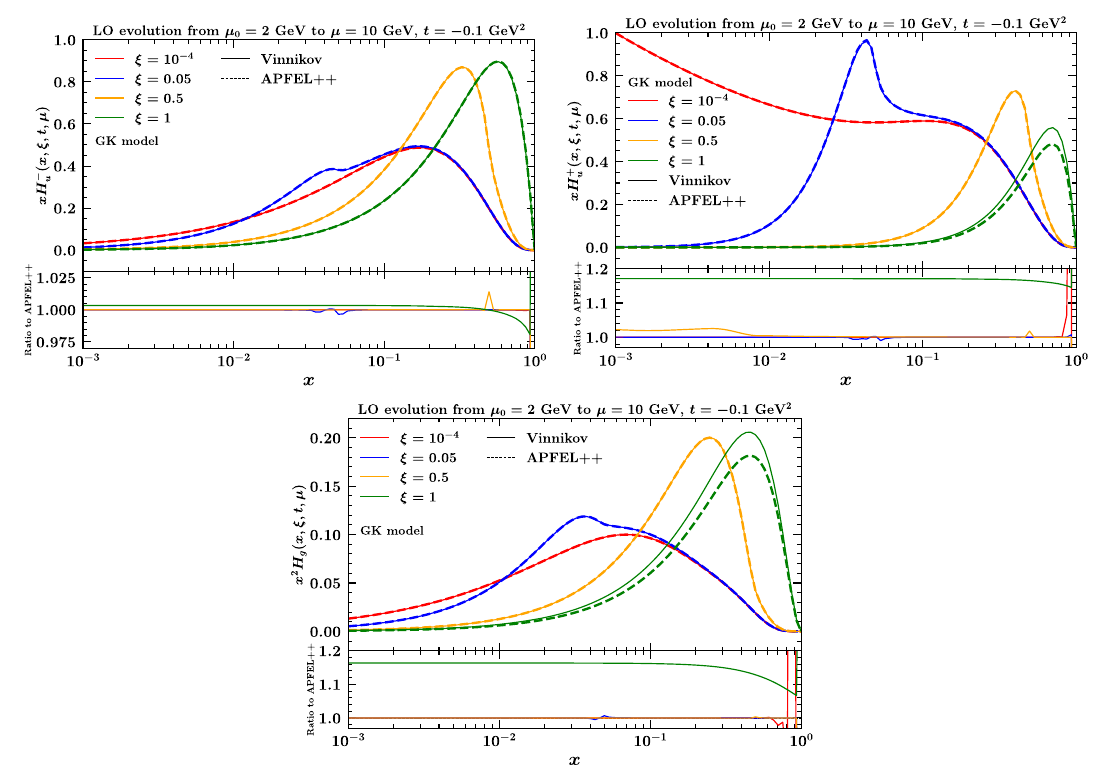
Fig. 7 Comparison between Vinnikov’s code [27] and APFEL++ . The evolution is performed at LO in the n f = 3 scheme (no threshold cross- ing) between the scales μ 0 = 2 GeV and μ = 10 GeV. As initial-scale